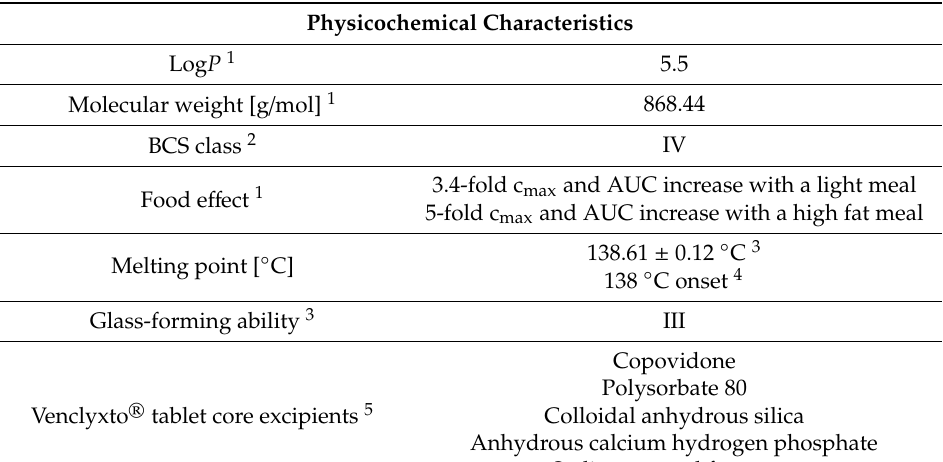
Table 1. Physicochemical properties and in vivo data of